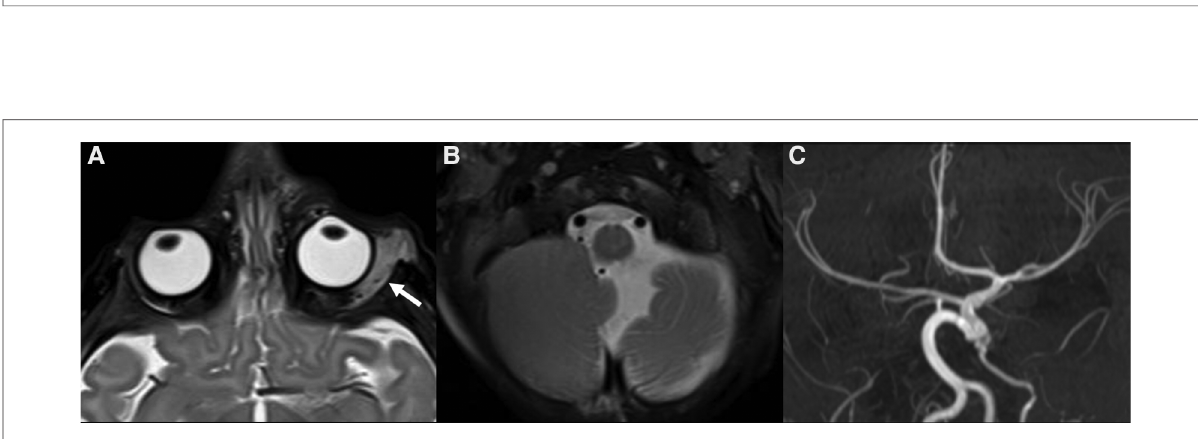
FIGURE 5 Mr images of a 6-month-old girl with known PHACES. Axial T2 ( A ) and contrast-enhanced T1 weighted images ( B,C ) show a diffuse segmental hemangioma of the right orbital, malar and auricular regions. Coronal dynamic MR angiography during gadolinium injection ( D – F ) shows the “ progressive fi lling ” of the vascular lesion. Also note in ( C ) the small enhancing mass in the right internal auditory canal (white arrow), consistent with an intracranial hemangioma, and the ipsilateral cerebellar hypoplasia.